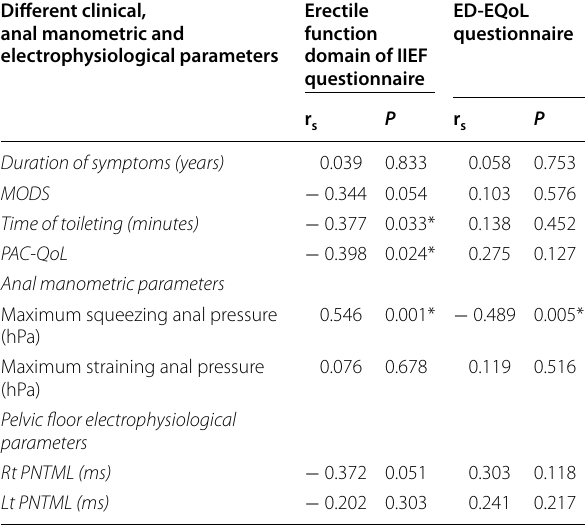
Table 4 Correlation between erectile function domain of International Index of Erectile Function questionnaire and Erectile Dysfunction-Effect on Quality of Life questionnaire with different assessed parameters among patient group with erectile dysfunction (n 32 patients) =